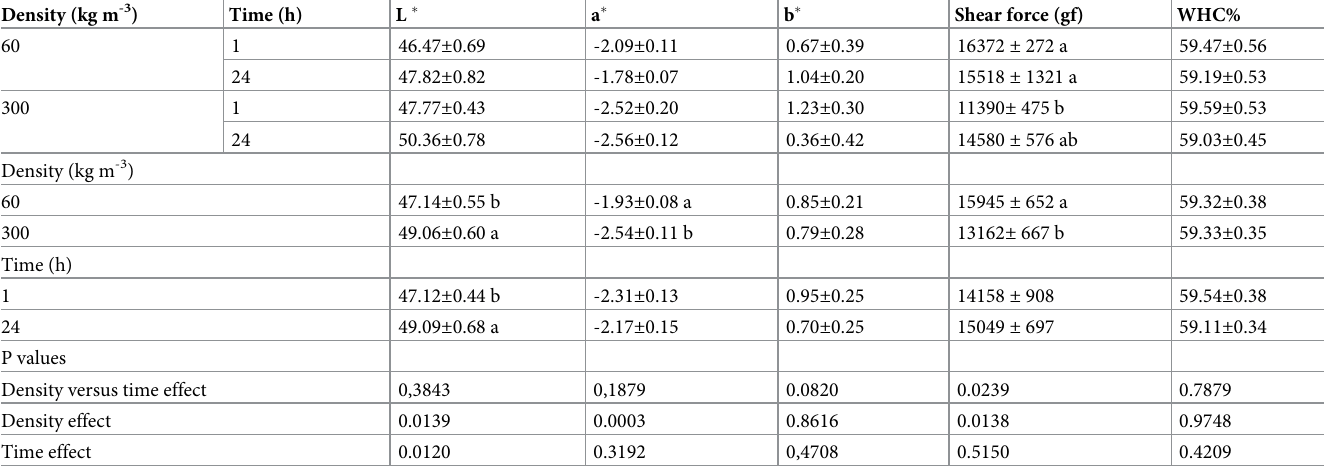
Table 3. Color parameters (L � , a � and b � ), shear force and water-holding capacity (WHC%) of Nile tilapia fillets at different densities (60 and 300 kg m -3 ) and depuration times (1 and 24